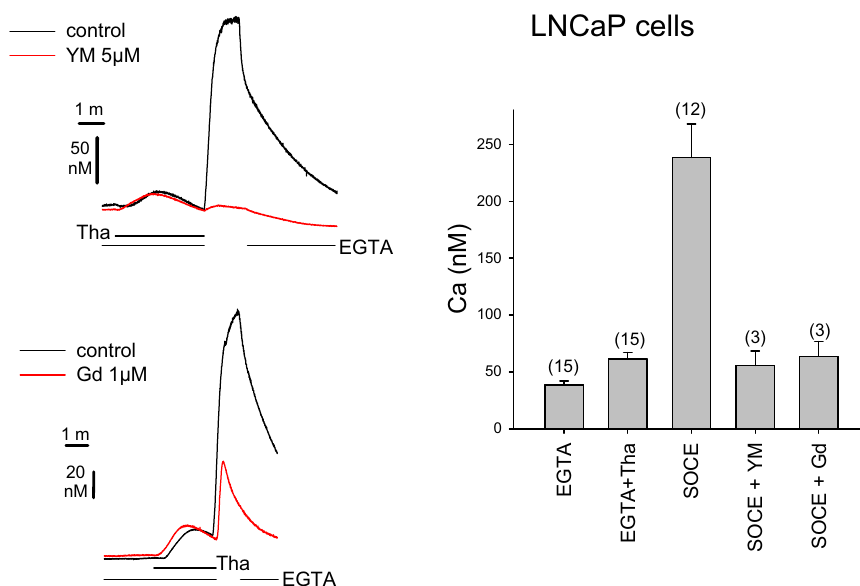
Figure 3: E ff ect of modi fi ers on the SOCE [ Ca 2 + ] i response in LNCaP cells. On the left, traces show the e ff ect of YM - 58483 ( above ) and 1 µM Gd ( below ) on LNCaP SOCE response. The graph on the right shows the summary of the e ff ects on SOCE [ Ca 2 + ] i response of the two modi fi ers in LNCaP cells. Lines represent SEM over the indicated number of experiments.